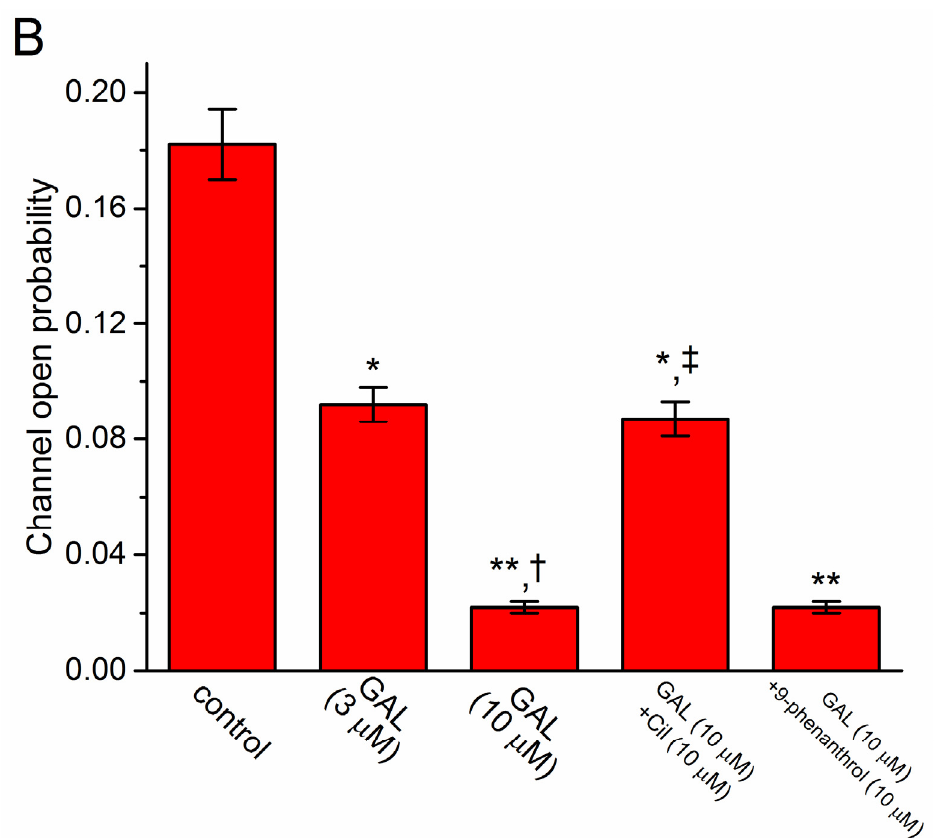
Figure 3. Suppressive e ff ect of GAL-021 on the activity of BK Ca channels identified in GH 3 cells. In these experiments, cells were immersed in high K + solution containing 0.1 µ M Ca 2 + , inside-out current recordings were performed, and channel activity was measured at the level of + 60 mV. The upper or lower part in ( A ) shows original channel current traces or the probability of channel openings, respectively. Horizontal bar indicates the addition of 10 µ M GAL-021 into the bath. The left (control) or right (during the exposure to GAL-021) current traces in the lowest part of ( A ) corresponds to the expanded records from dashed boxes in the upper part. Channel-opening event is denoted as an upward deflection (i.e., outward current). Of note, there is a progressive decrease in the channel open probability during the exposure to GAL-021 (10 µ M). ( B ) Summary bar graph showing e ff ect of GAL-021, GAL-021 plus cilostazol, and GAL-021 plus 9-phenanthrol on the probability of BK Ca -channel openings (mean ± SEM and n = 6 to 8 for each bar). Inside-out current recordings were taken and the open-state probability of the channel was measured at + 60 mV. * Significantly di ff erent from control ( p < 0.05); **, significantly di ff erent from control ( p < 0.01); † significantly di ff erent from GAL-021 (3 µ M) alone group ( p < 0.05); and ‡ , significantly di ff erent from GAL-021 (10 µ M) alone group ( p < 0.05). Cil, 10 µ M cilostazol and GAL, GAL-021.